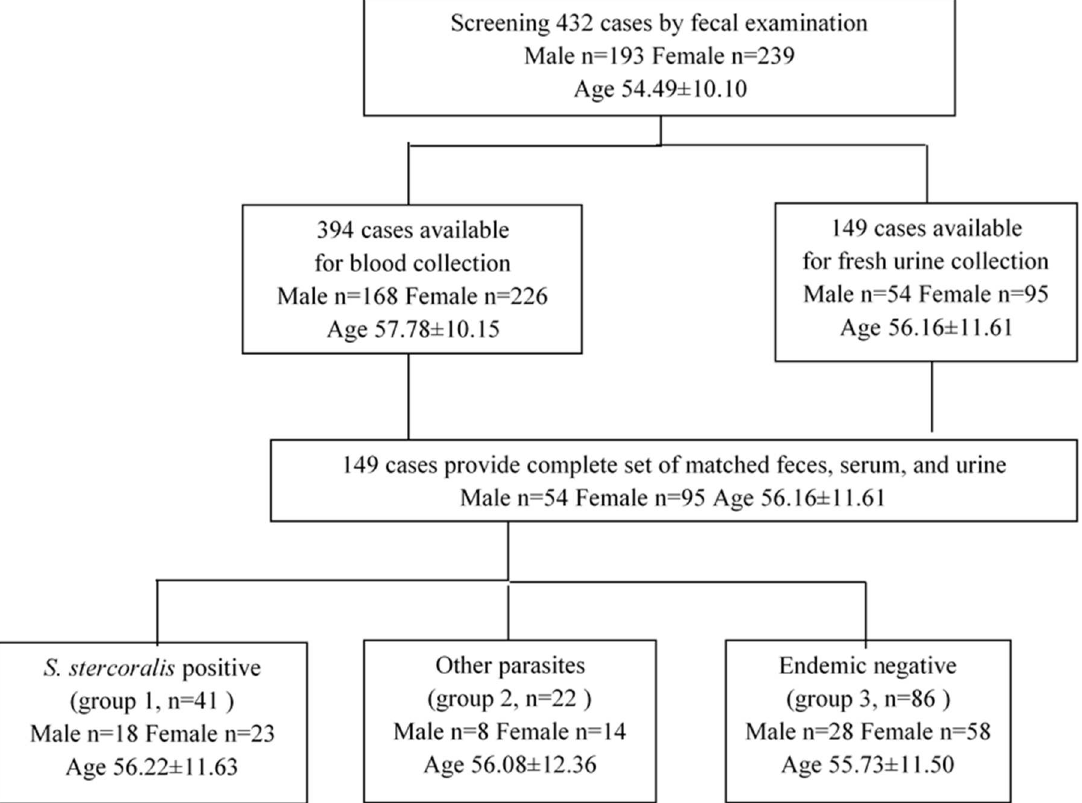
Fig 1. Flow chart of participants in the study. Data shown for age are mean ± SD, where n is the sample size.